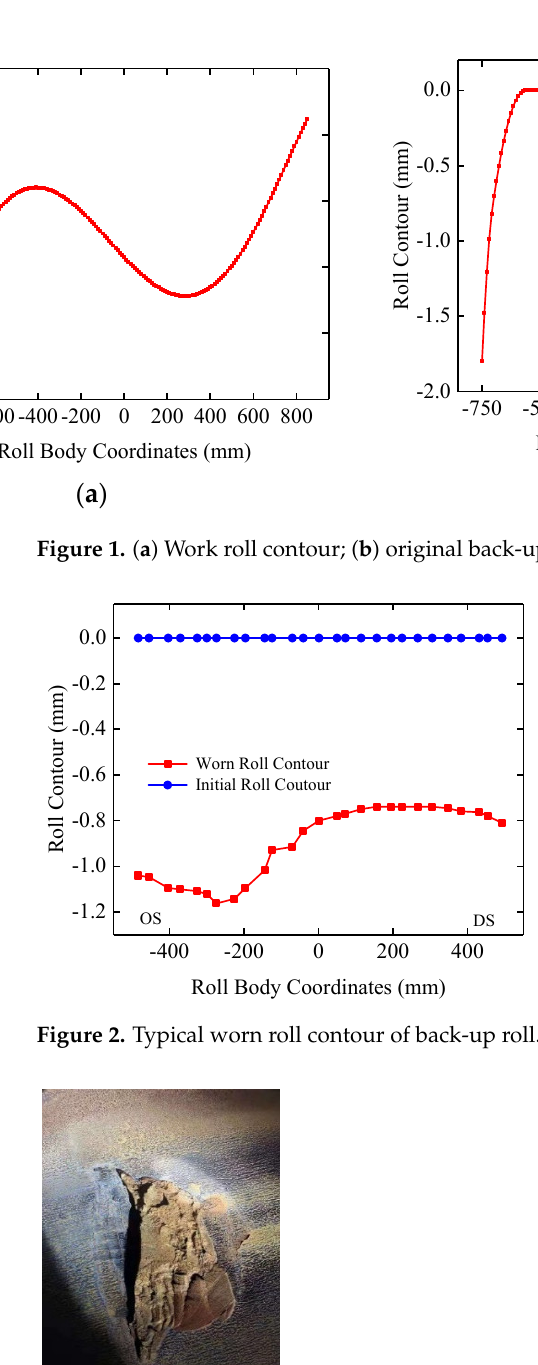
Figure 3. Back-up roll surface spalling.